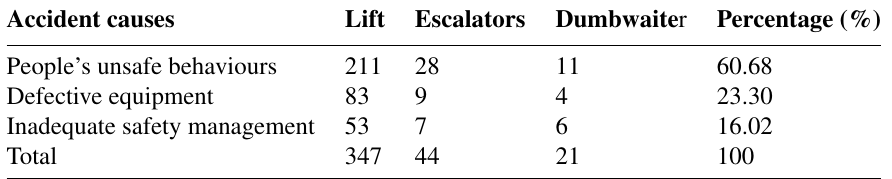
Fig. 6 Statistical investigation of elevator accident types. (a) The statistics of accident types for all types of elevators. (b) The statistical investigation of elevator accident types in escalators (passenger conveyors included). (c) The accident type statistics of dumbwaiters. (d) The accident type statistics of lifts. Table 4 Statistics on the causes of typical elevator accidents in China from 2002 to 2019. Accident